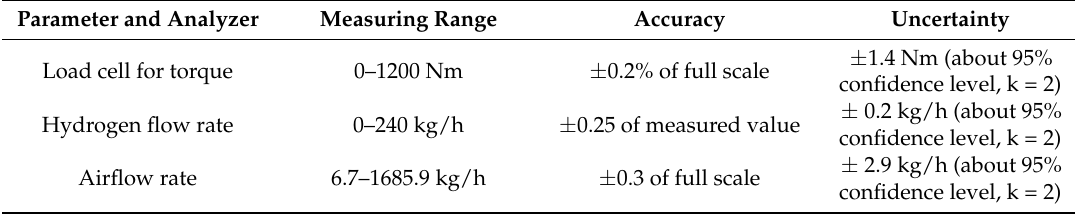
Table 3. Specifications of each flow and torque measurement